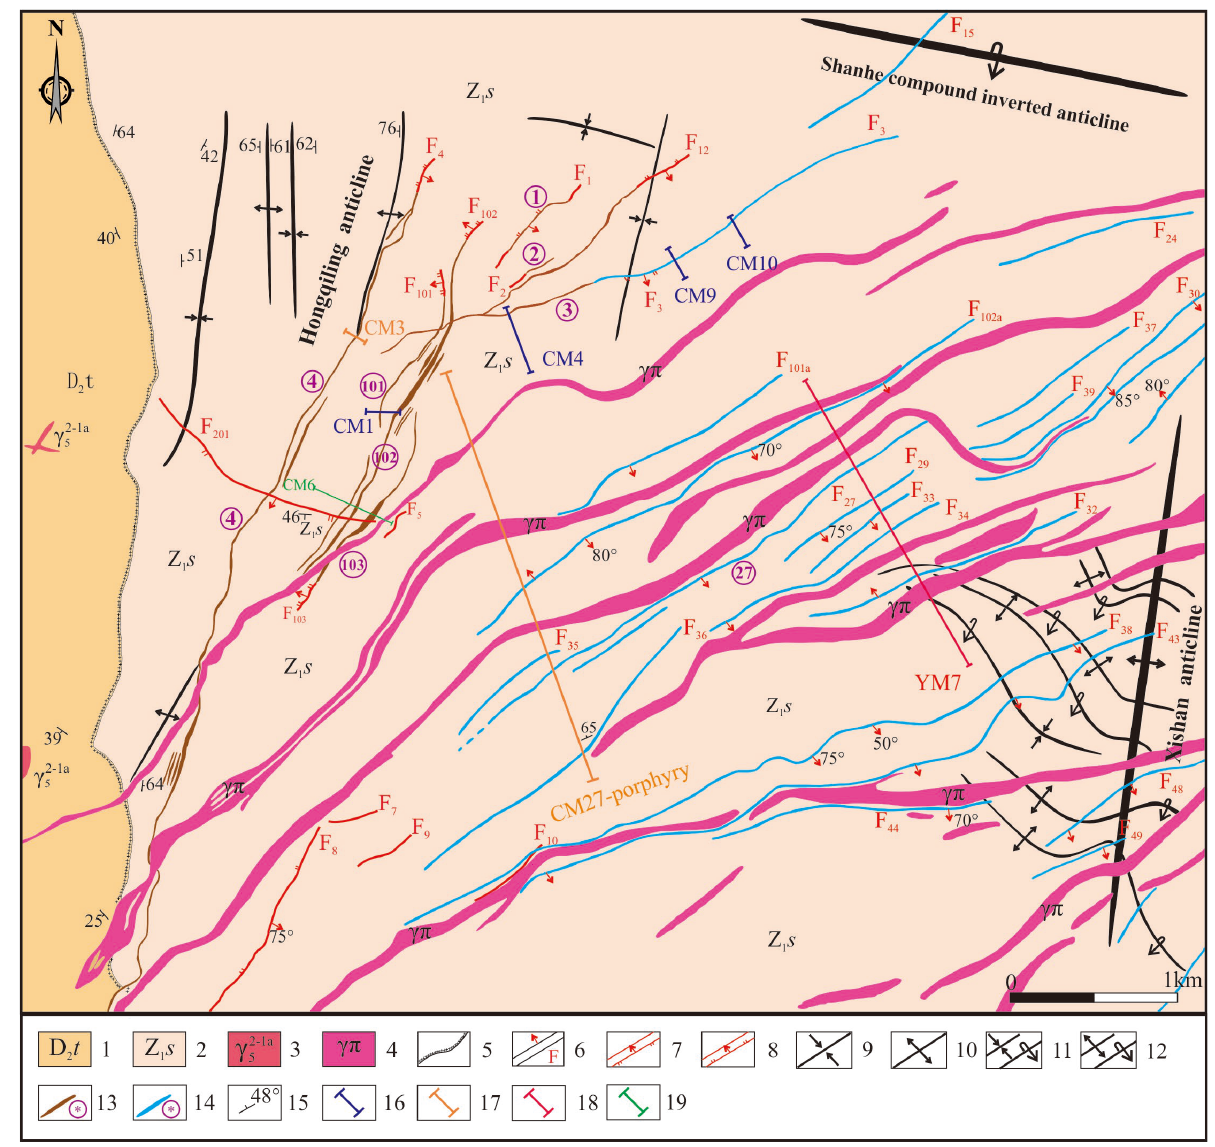
Figure 2. Geological sketch of Hongqiling mining area (after [45]). 1. Middle Devonian Tiaomajian Formation; 2. Lower Sinian Sizhoushan Formation; 3. The first intrusive marginal phase of Early Yanshanian granite (2nd member of Qianlishan Formation); 4. Granite porphyry; 5. Unconformity; 6. Fault and number; 7. (inferred) reverse fault; 8. (inferred) normal fault; 9. Syncline; 10. Anticline; 11. EW-trending secondary syncline and inverted anticline; 12. EW-trending secondary anticline and inverted oblique; 13. Sn veins and their numbers; 14. Pb-Zn veins and their numbers; 15. Stratigraphic occurrence; 16. 836m mine level; 17. 766m mine level; 18. 600m mine level; 19. 420m mine level.